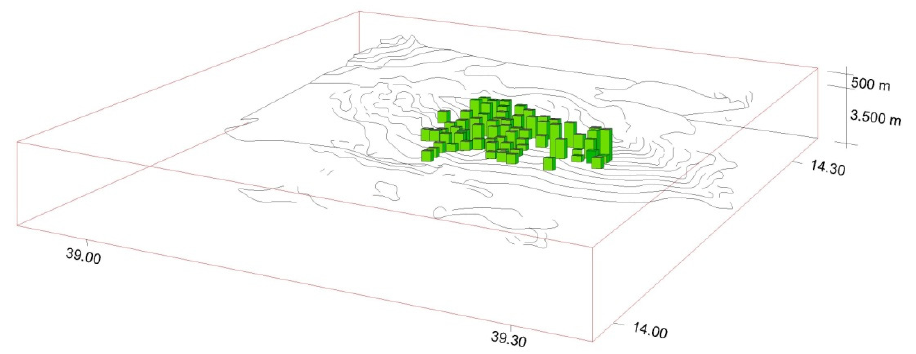
Figure 4. 3D inversion model of the magnetic anomaly field with the geometric reconstruction of the Marsili geothermal reservoir (a 100 km 3 estimated volume) (courtesy of INGV).